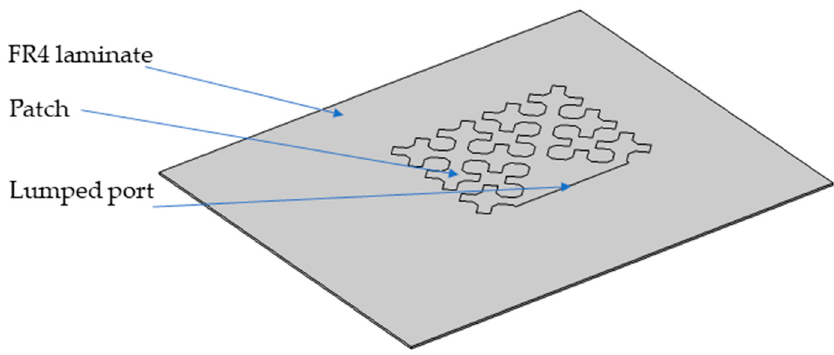
Figure 8. Fractal MPSS feed without transmission line. Table 2. Shift of resonant frequency for proposed sensors feed with microstrip line and without it.